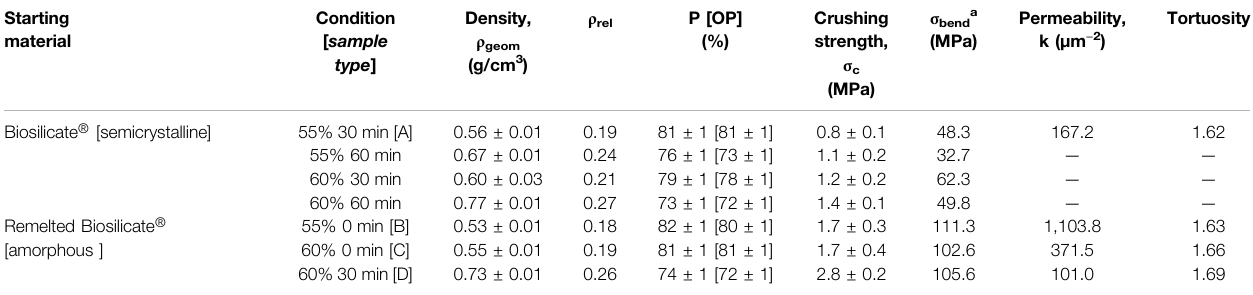
TABLE 1 | Physical and mechanical properties of Biosilicate ® glass-ceramic foams. Starting material